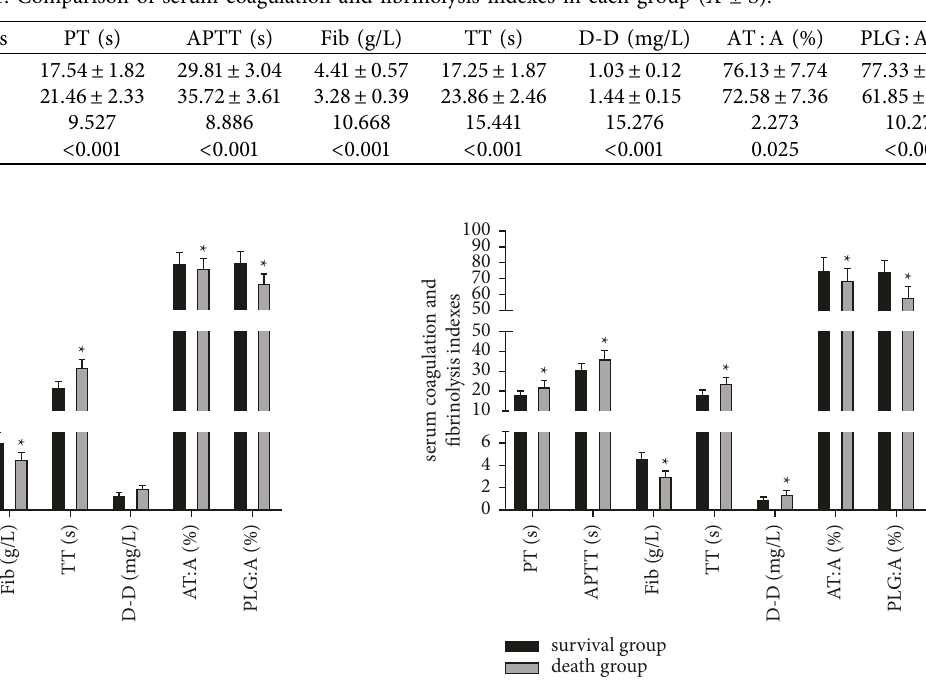
Table 1: Comparison of serum coagulation and fibrinolysis indexes in each group ( X